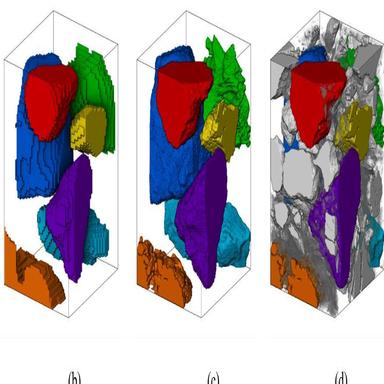
3D visualization of loess microstructure based on images from μXCT and FIB-SEM. (a) Seven silt-sized skeleton particles extracted from μXCT as numbered from 1 to 7, with the individual view and equivalent diameter of each particle listed aside. (b) and (c) The seven skeleton particles included in the ROI extracted from μXCT and FIB-SEM respectively. (d) FIB-SEM results displaying additional particles and fine clays that are not resolved by μXCT.